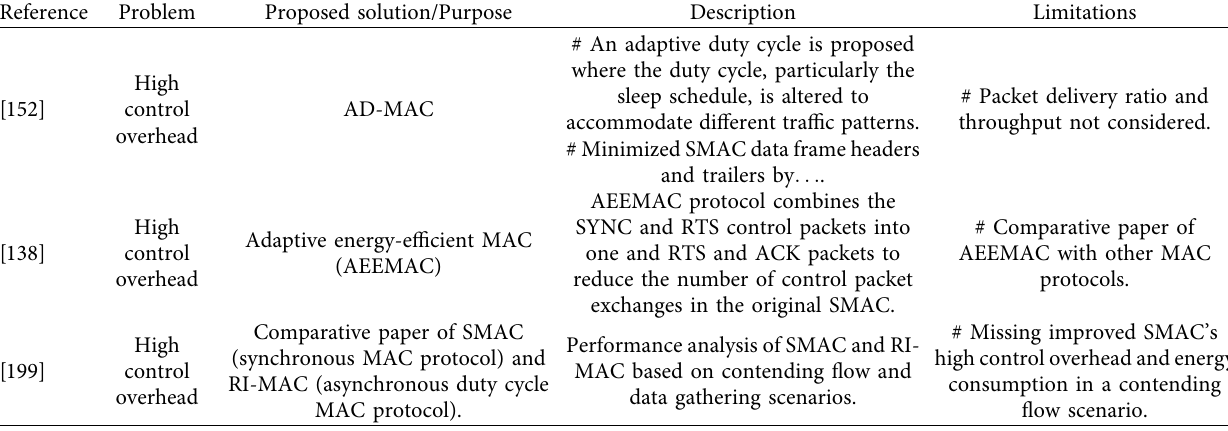
Table 8: Enhanced protocols/algorithms for high control overheads in SMAC protocol.